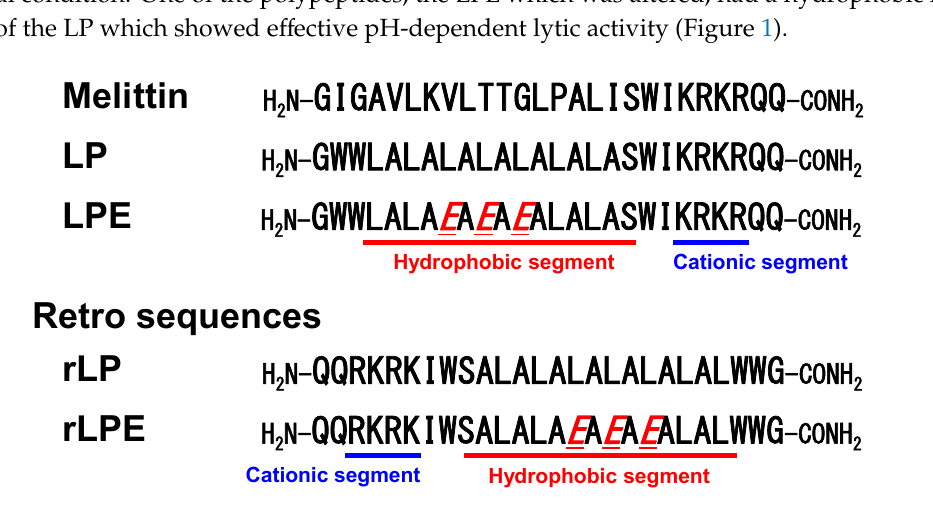
Figure 1. Amino acid sequences of melittin-inspired membrane lytic polypeptides and their retro isomer polypeptides.